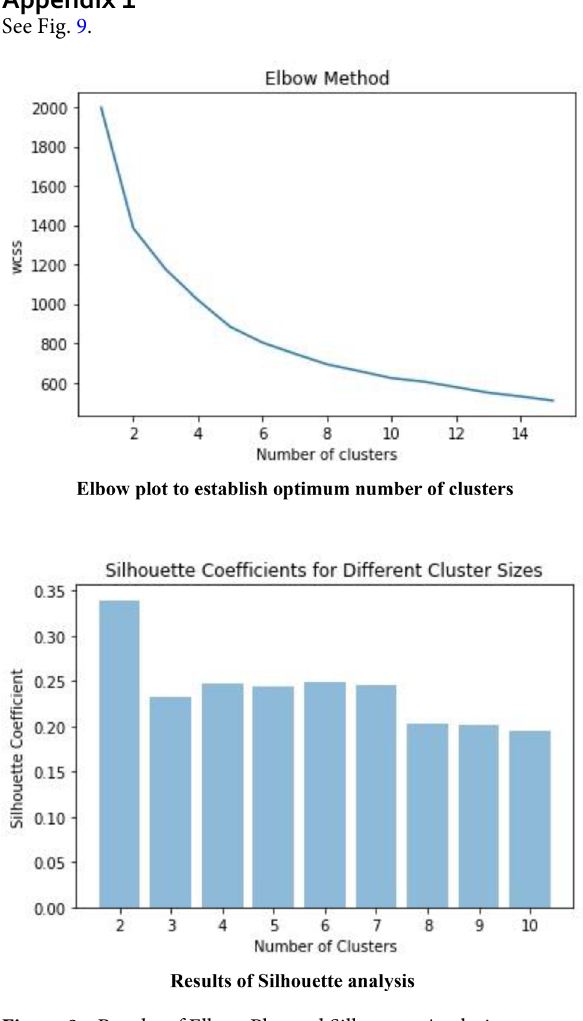
Figure 9. Results of Elbow Plot and Silhouette